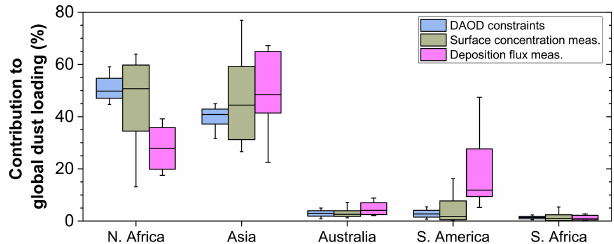
Figure 9. Optimal fractional loading per source region that opti- mizes agreement against constraints on DAOD (blue bars; these are the inverse model results reported in this paper and in Kok et al., 2021a) and against measurement compilations of surface concentra- tion (dark yellow bars) and deposition flux (pink bars). Box bound- aries and whiskers respectively denote the 68% and 95% probabil- ity range, and horizontal solid lines denote the median result. The North American source region was omitted, and the three North African source regions (western North Africa, eastern North Africa, and southern Sahara and Sahel) and the two Asian source regions (Middle East–central Asia and East Asia) were grouped together to avoid overfitting (see the Supplement for further